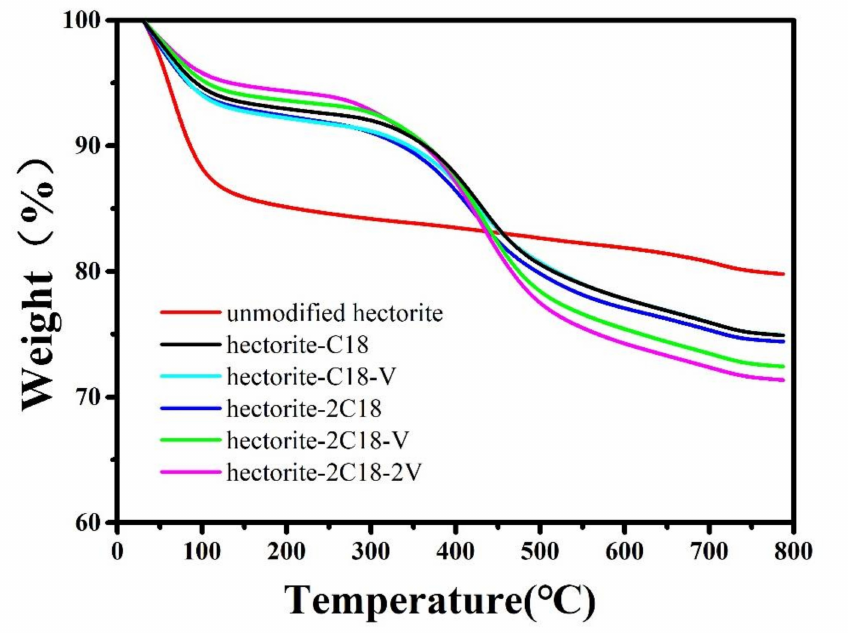
Figure 2. TGA degradation profiles of unmodified and modified hectorite prepared with different OTES/VTMS